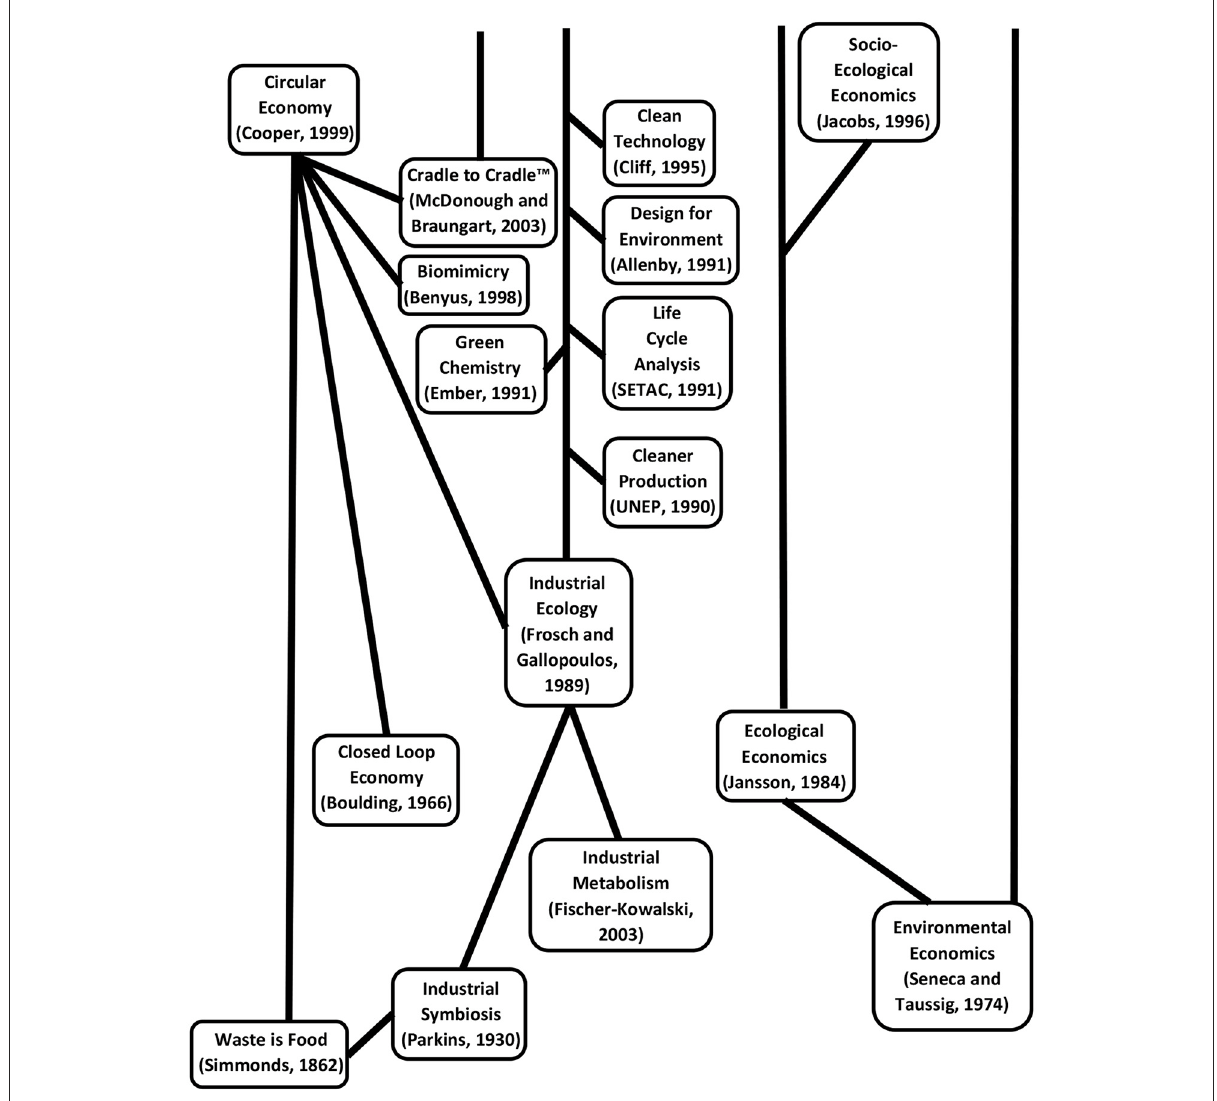
FIGURE3 The phylogeny of current sustainable economy schools over